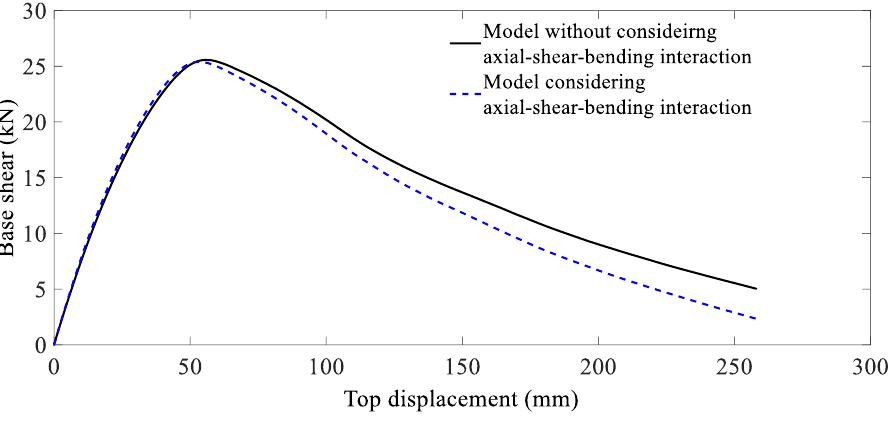
Figure 13. Comparison of pushover curves.